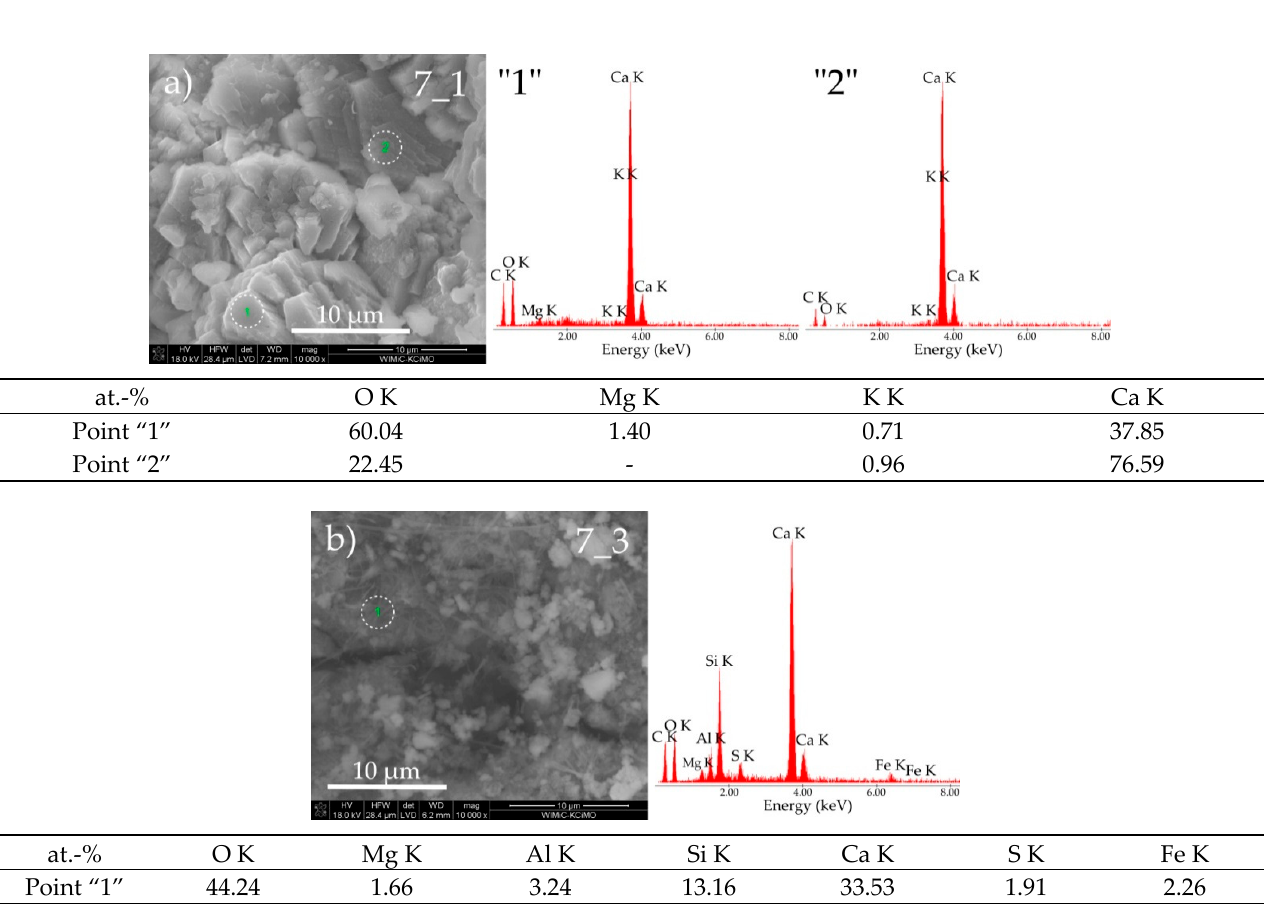
Figure 9. SEM micrographs of cement paste 7 obtained after exposure under the conditions of ( a ) water (sample 7_1) and ( b ) pig slurry (sample 7_3) with EDS quantitative point analyses from areas 1 and 2.